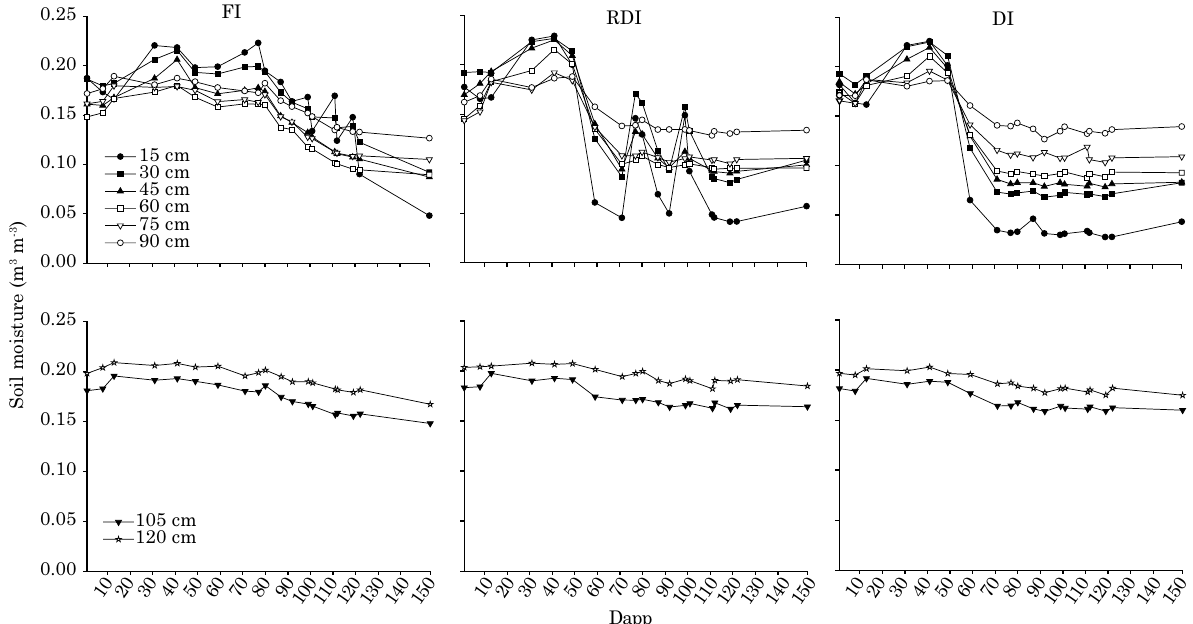
Figure 1. Soil moisture (θ) at the 15, 30, 45, 60, 75, 90, 105, and 120 cm depths in accordance with irrigation strategies, with full irrigation - FI, regulated deficit irrigation - RDI, and deficit irrigation - DI. Dapp: days after production